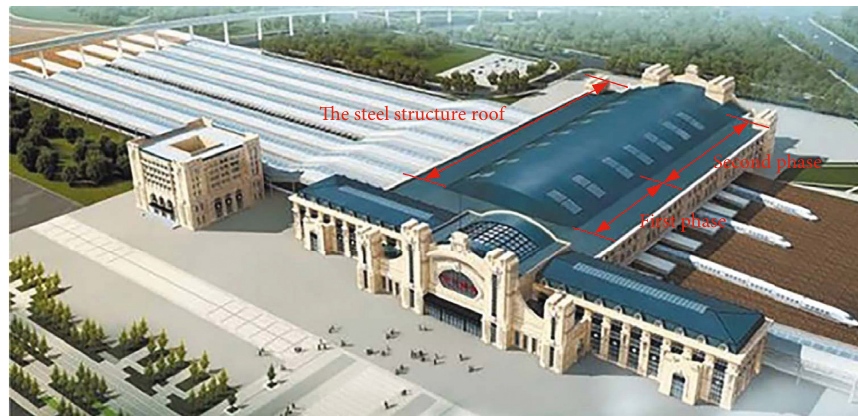
Figure 8: Harbin railway